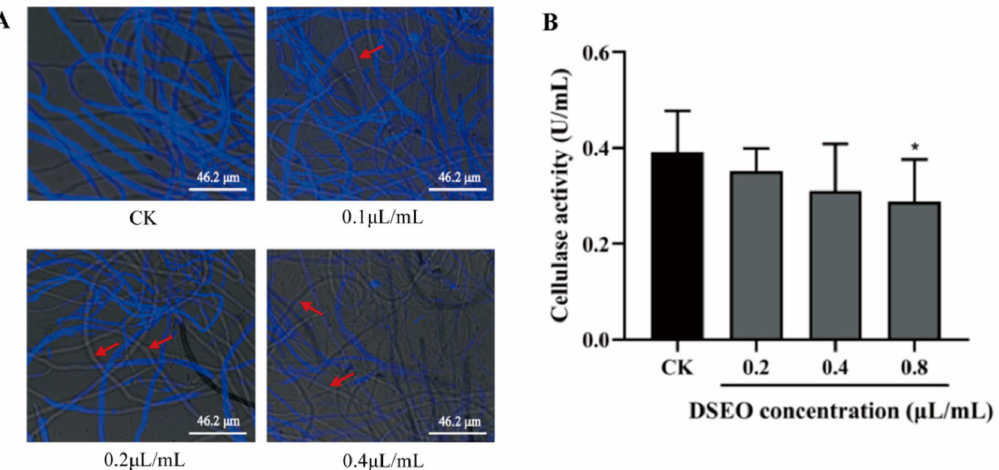
Figure 2. The effects of DSEO on the cell wall of N. parvum . ( A ) Merged images under confocal laser scanning microscopy (CLSM) white light and fluorescence after staining with calcium fluorescent white (CFW); Clear changes were marked with arrows. ( B ) The effect of DSEO on the cellulase activity of N. parvum . “CK” represents “control”. Statistical significance was set at * p < 0.05.